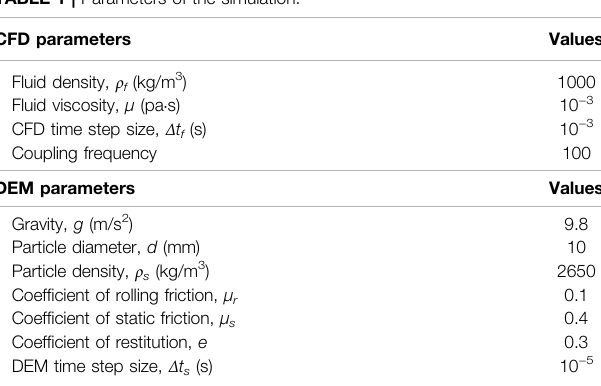
TABLE 1 | Parameters of the